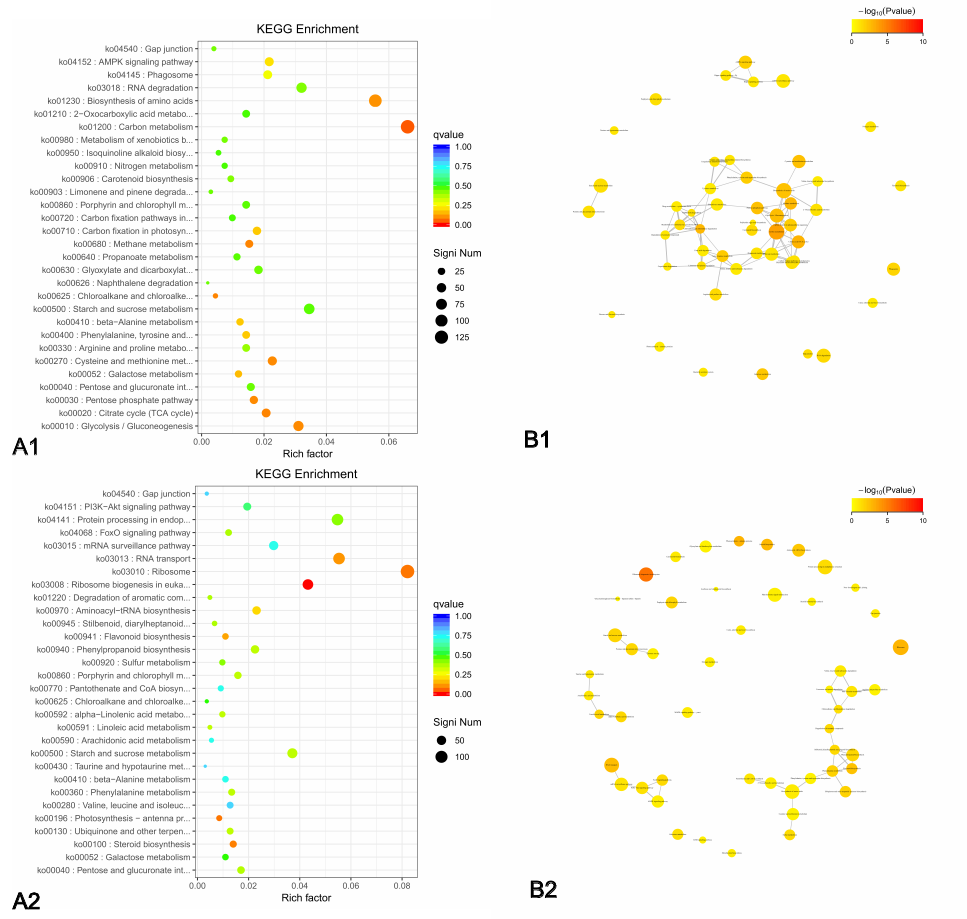
Figure 3. Three study regions in California. Figure 4. Pathway and functional analysis of DEGs: ( A ) a scatter map of significantly enriched Kyoto Encyclopedia of Genes and Genomes (KEGG) functional terms using clusterProfiler (the color of the nodes represents the enrichment degree of the function (as the p -value); the higher the enrichment degree, the lower the p -value and the darker the color): ( A1 ) DEGs for HP-3 vs. HC-3; ( A2 ) DEGs for HP-3 vs. HS-3. ( B ) Functional interaction network of KEGG enrichment terms using the igraph package in R (the metabolism of xenobiotics by cytochrome P450 is marked in red): ( B1 ) DEGs for HP-3 vs. HC-3; ( B2 ) DEGs for HP-3 vs. HS-3. Green represents downregulation, and red represents upregulation; p -value < 0.05 and | FoldChange | >